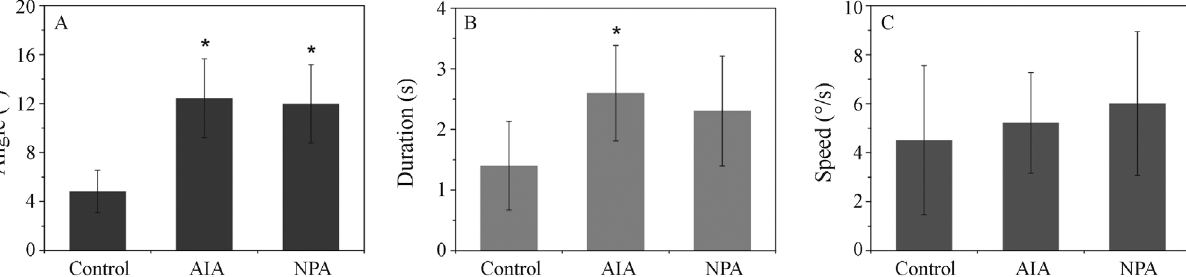
Figure 2 - Effect of the IAA and NPA treatments on the movement dynamics of the P. sanguinolenta androgynophore. (A) Movement amplitude mea- sured by the angle formed between the initial state (before the movement) and the final state (after the movement) in degrees. (B) Duration of the move-